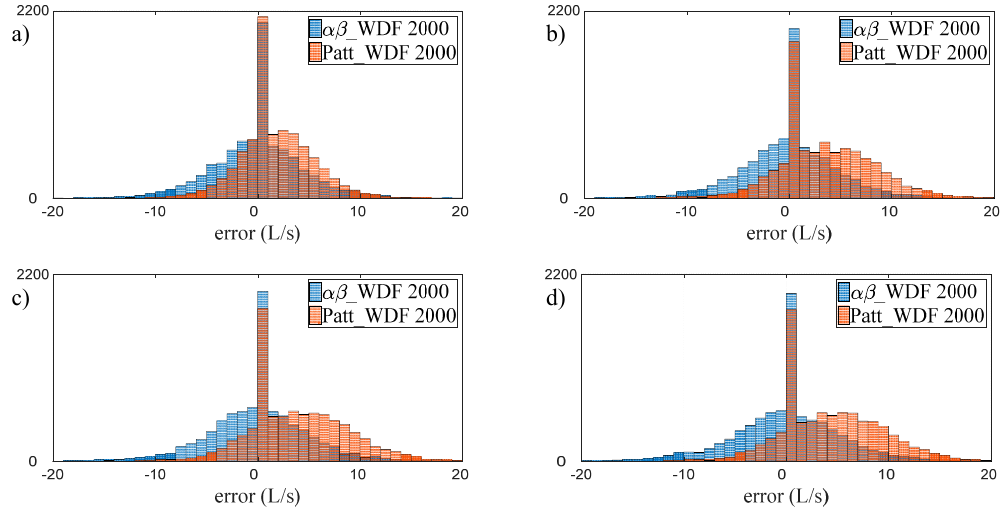
Figure 5. Comparison of the forecasting error frequency histograms of the αβ _WDF and Patt_WDF models for the year 2000 and the time horizons of ( a ) 1 h; ( b ) 6 h; ( c ) 12 h; and ( d ) 24 h.